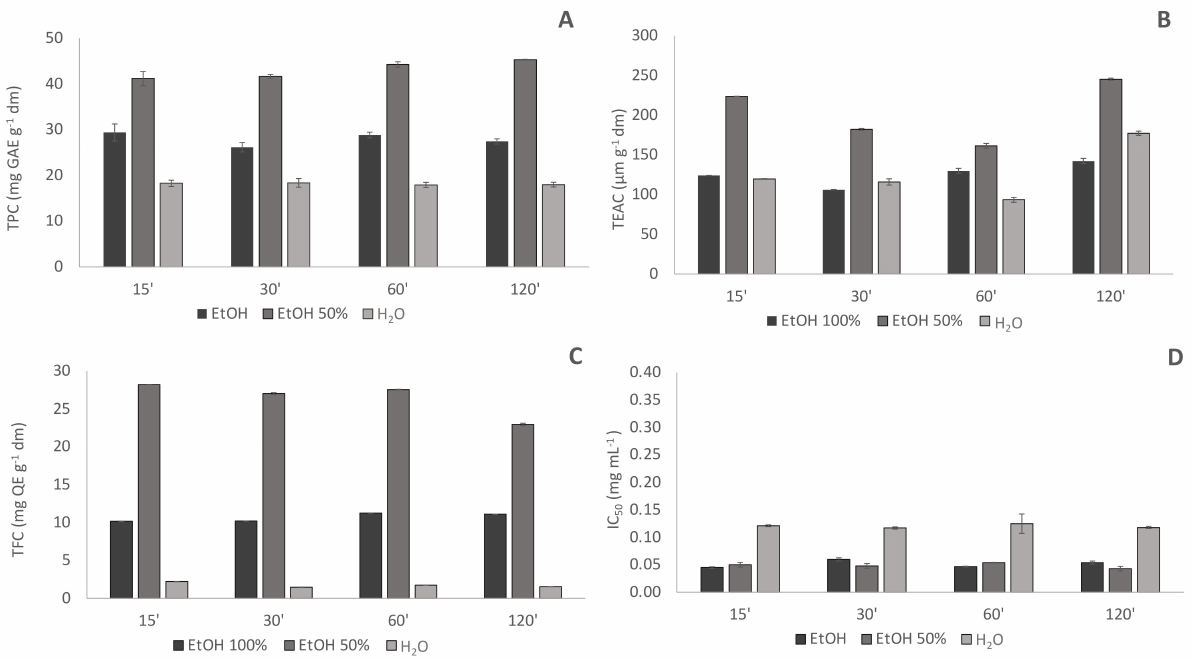
Figure 1. Comparison of phenolic content and antioxidant capacity of pure ethanol (EtOH); water (H 2 O) and ethanol water 50:50 ( v / v ) (EtOH 50%) hop extracts obtained by conventional extraction at 60 ◦ C (CONV 60 ◦ C); ( A ) TPC: Total Phenolic Content (mg GAE g − 1 dm); ( B ) TEAC: Trolox Equivalent Antioxidant Capacity ( µ mol g − 1 dm); ( C ) TFC Total Flavonoids Content (mg QE g − 1 dm); ( D ) antiradical capacity express as Inhibitory Capacity IC50 (mg mL − 1 ); 15 (cid:48) , 30 (cid:48) , 60 (cid:48) , 120 (cid:48) : extraction times in minutes.